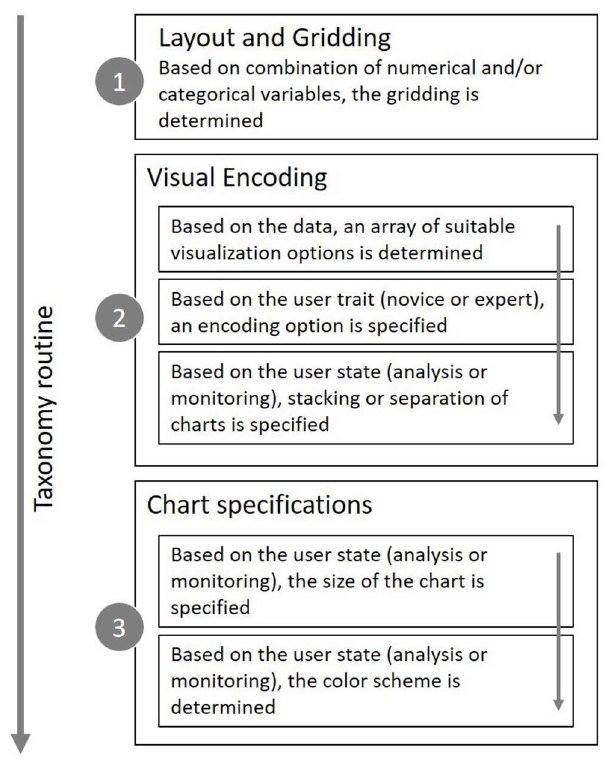
FIGURE 5 | Adaptive taxonomy calculcation steps to determine layout, encoding and